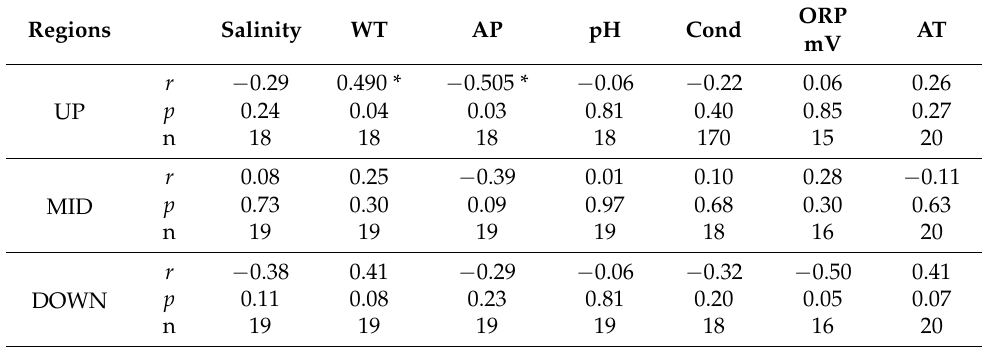
Table 2. Correlations among CH 4 fluxes and environment factors.